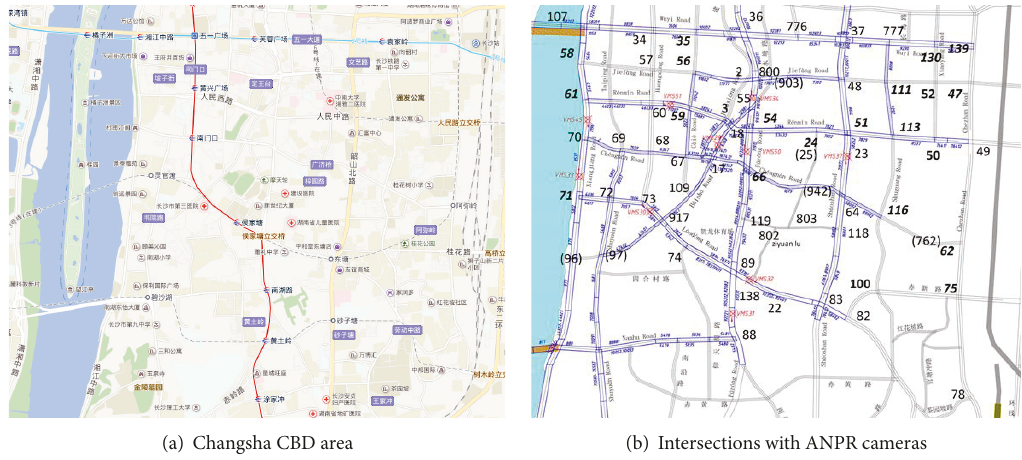
Figure 2: The selected network in Changsha City, China.